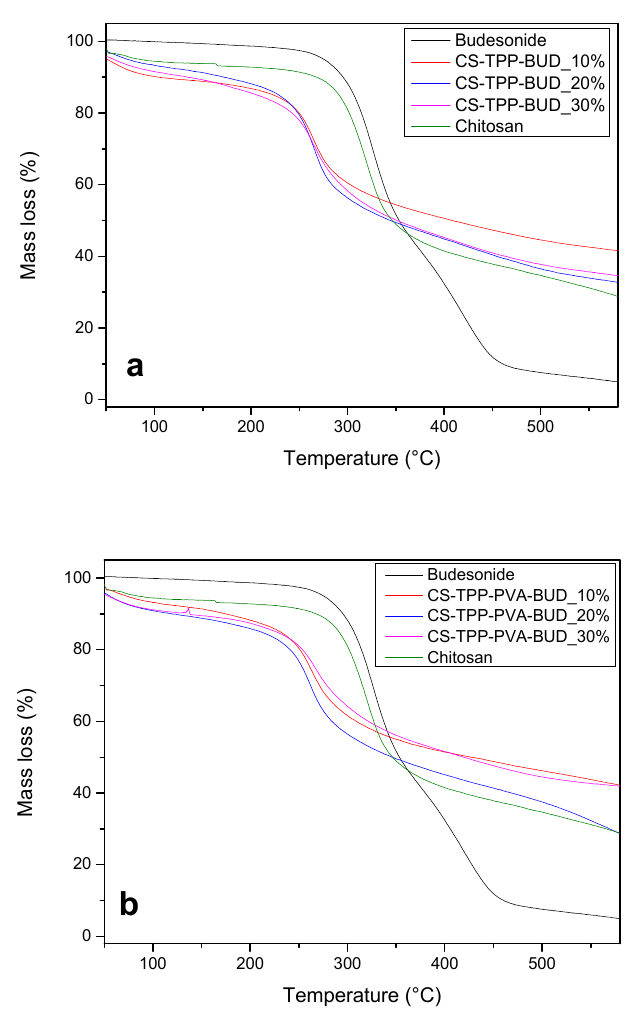
Figure 7. TGA thermograms of CS, BUD and chitosan nanoparticles containing BUD ( a ) without emulsifier and ( b ) with emulsifier.